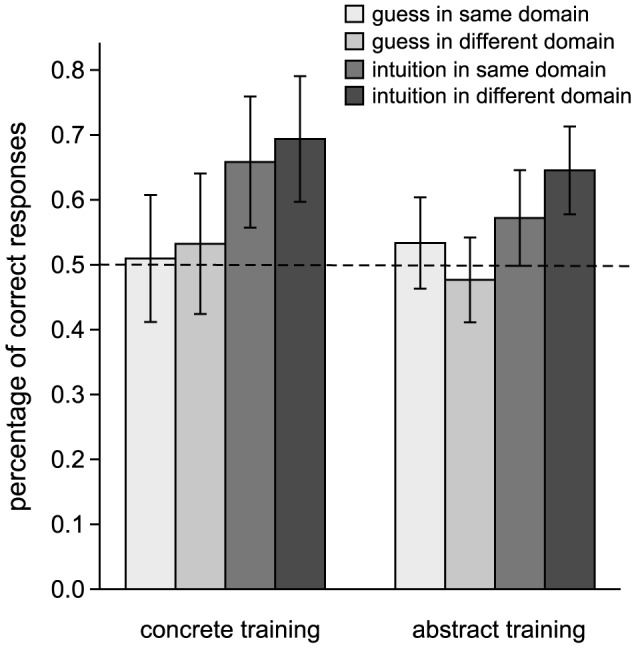
Percentage of correct responses by guess and intuition attributions for each condition.Error bars indicate 95% confidence interval.